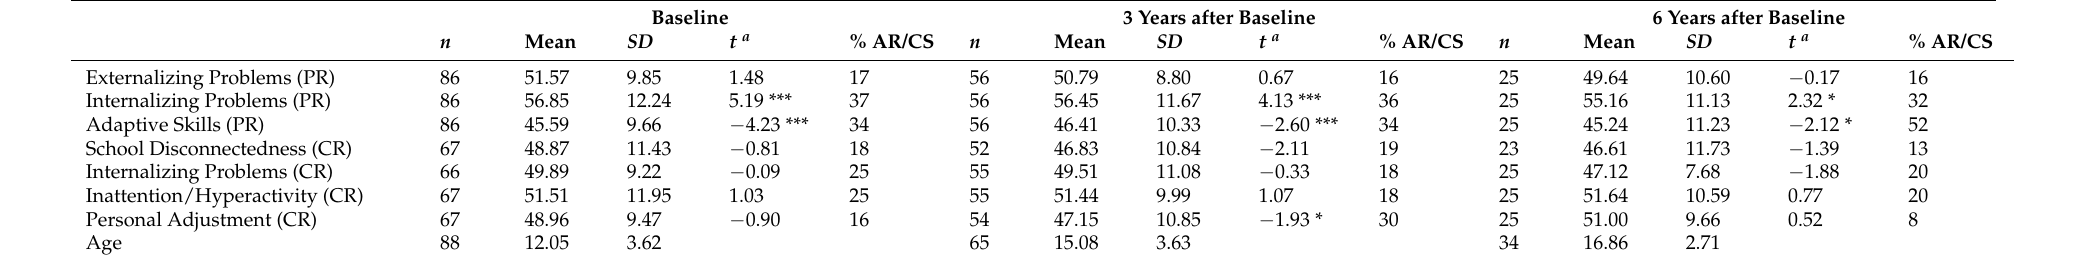
Table 1. Descriptive Statistics and T -Test Results for Socioemotional Outcomes and Age at Each Assessment Time. Baseline 3 Years after Baseline 6 Years after Baseline